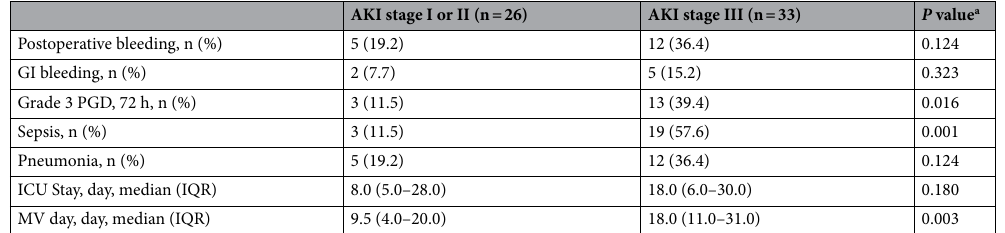
Table 4. Postoperative complications among lung transplant recipients according to AKI severity. Data are presented as number (%) or medians (interquartile ranges). GI bleeding gastrointestinal bleeding, PGD primary graft dysfunction, ICU intensive care unit, MV mechanical ventilation. a P value determined by t test or χ 2